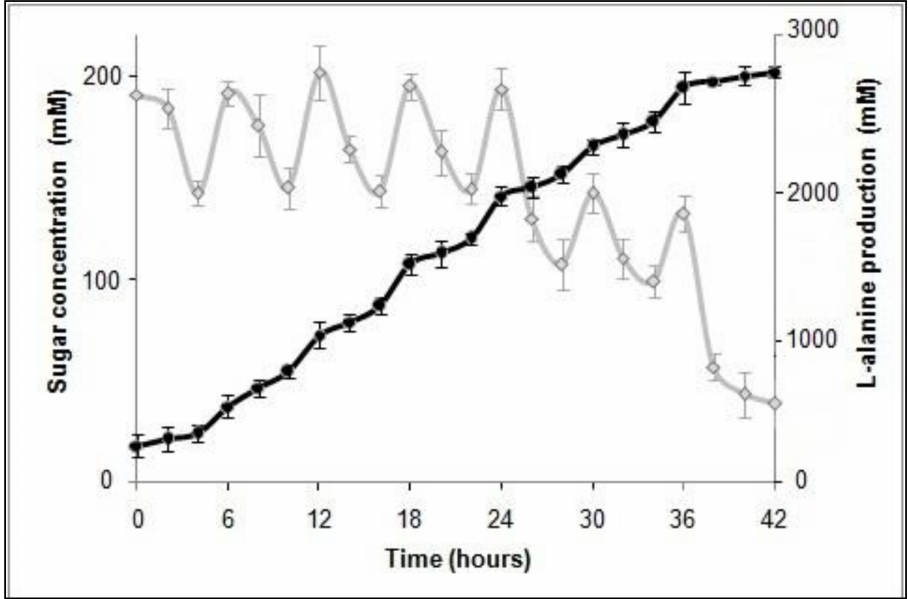
Figure 3. Fed-batch fermentation and production of L-alanine in the recombinant P. acidilactici BD16 ( alaD +